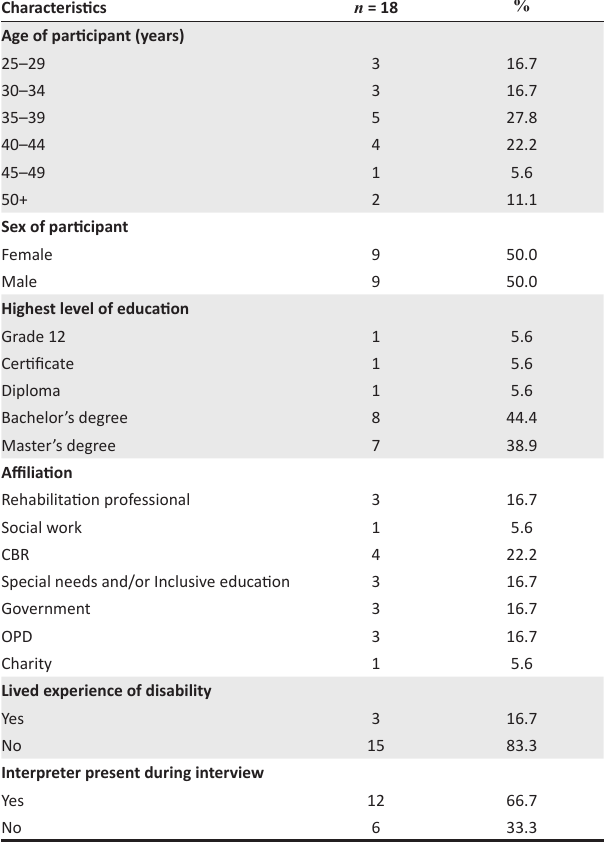
TABLE 1: Demographic characteristics of study participants.